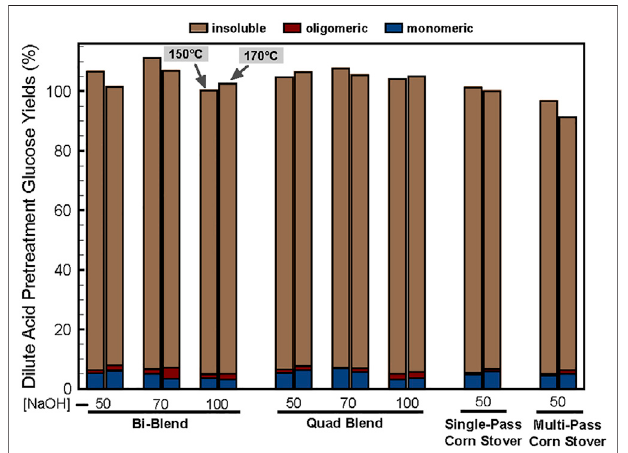
FIGURE 8 | Monomeric and oligomeric enzymatic hydrolysis glucose yieldsofDMRpretreatedfeedstocksat20%initialinsolublesolidsloading.The enzymatic hydrolysis was conducted at an enzyme loading of 12 mg total protein/g glucan using an 80:20 mixture of Novozymes Cellic CTec3/ HTec3 at 50 ° C for 7 days. Bars and error bars show the average and the standard deviation, respectively, of two replicated